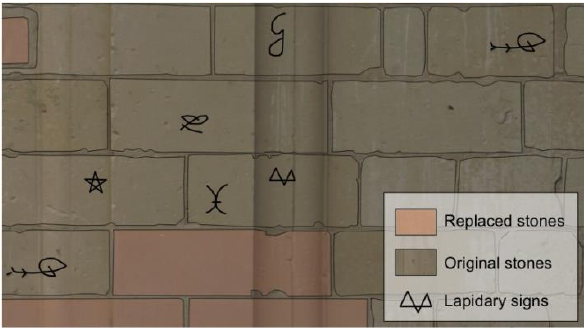
Figure 17 : Example of two kinds of metadata mapped on orthoimages: lapidary signs and stone